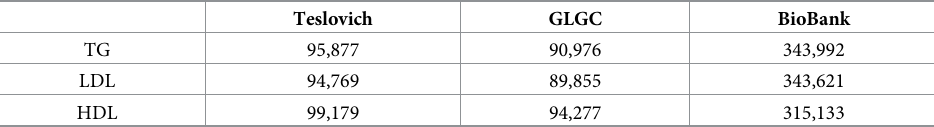
Table 1. Median sample size for each study in the lipid analysis.